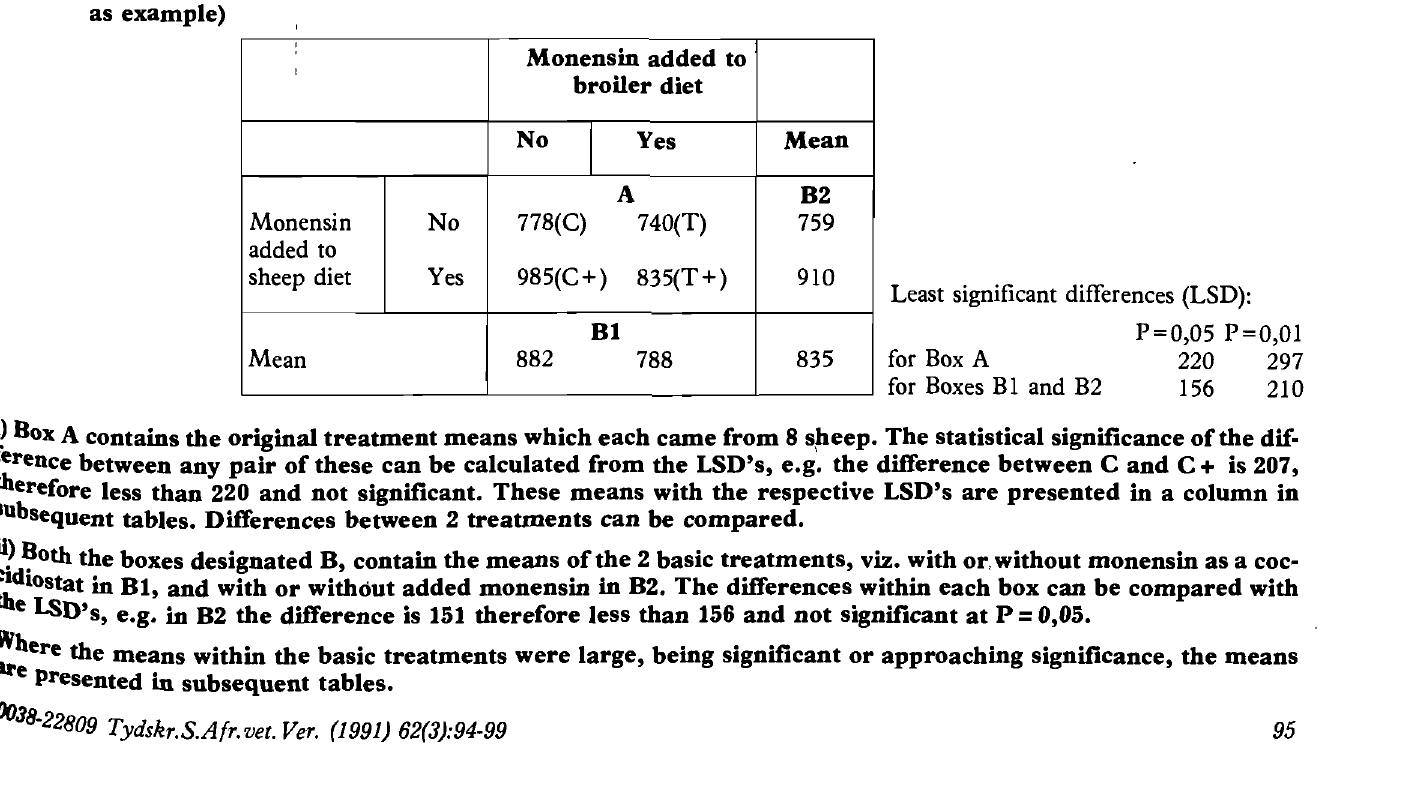
Table 1: An illustration of the interpretation ofa single 2x2 factorial analysis (Copper concentration in Table 6 used as